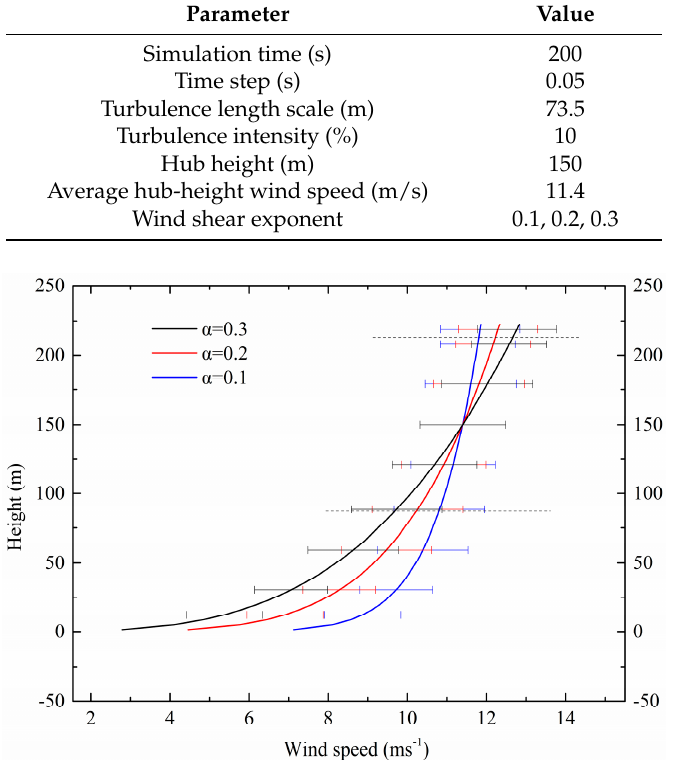
Table 2. The values of the main parameters in IEC Von Karman isotropic spectral model.